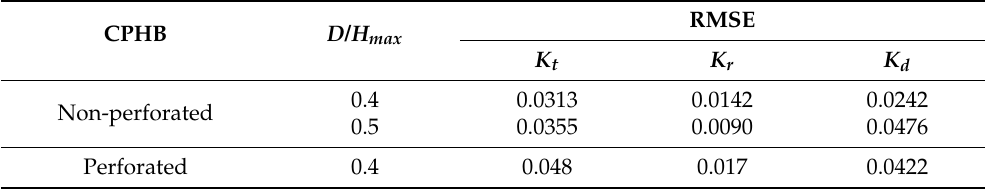
Figure 9. Comparison of numerical and experimental results for perforated CPHBs. Table 4. Comparison of experimental and numerical results using